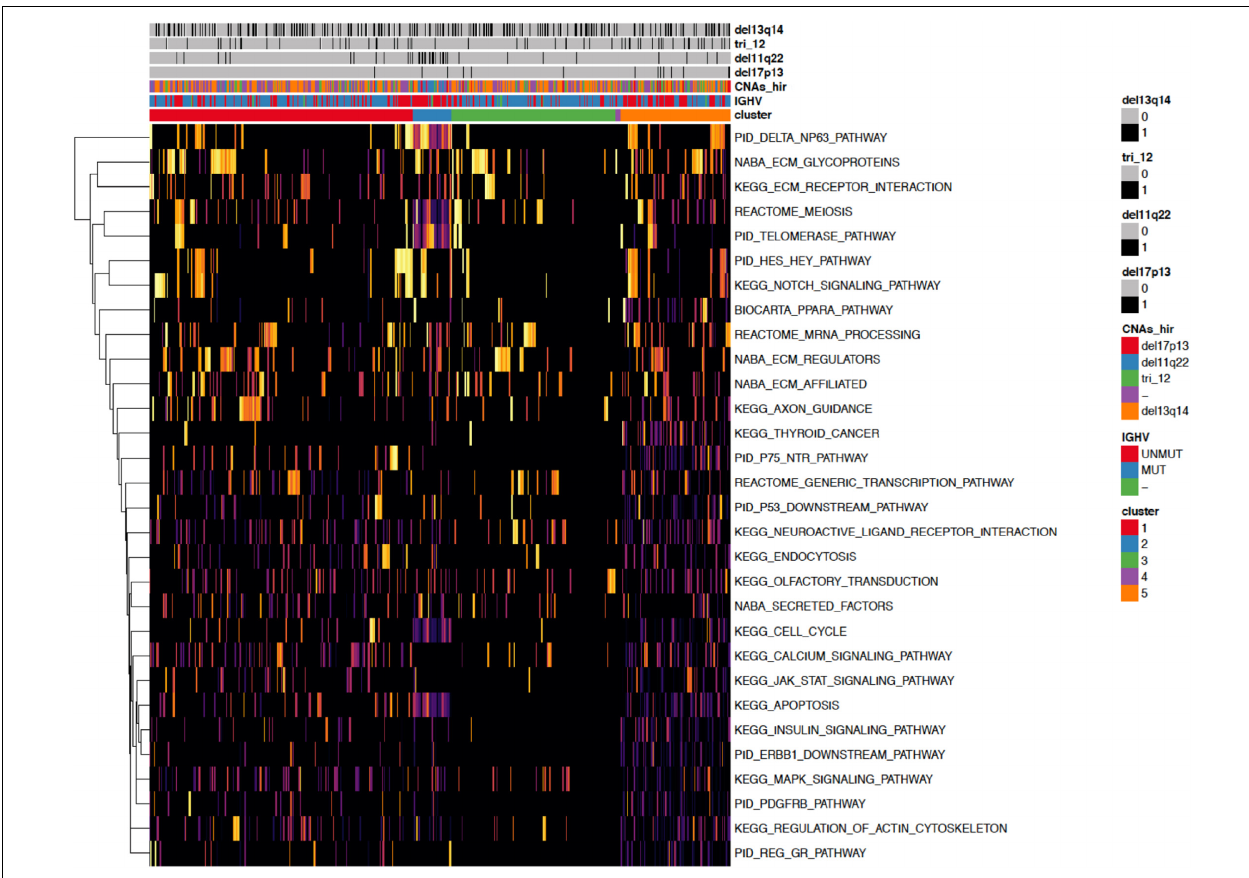
FIGURE 4 | A heatmap showing the 30 most important pathways for the classification model predicting the identified clusters. Copy number alterations are displayed individually and hierarchically clustered according (Döhner et al.,